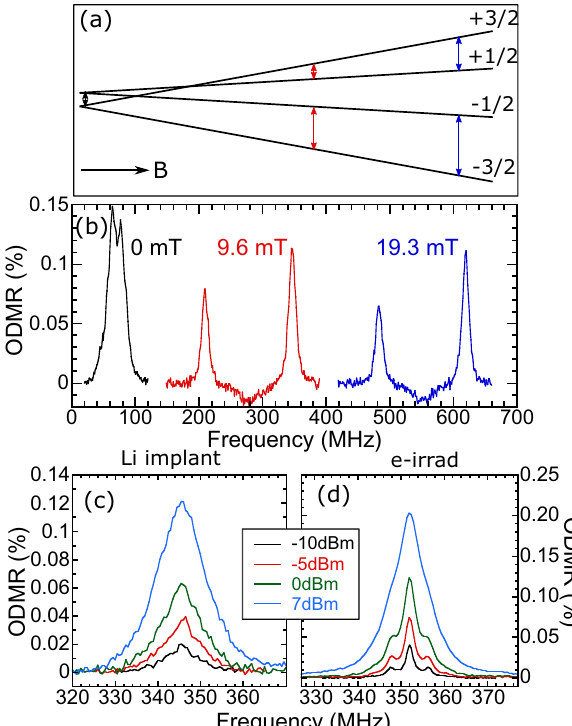
Figure 4. ( a ) Energies of the ground state S = 3/2 spin states of V 2 as a function of magnetic field along the c -axis, with arrows representing the ODMR transitions. ( b ) Room temperature ODMR of 5 × 5 µm square implanted at 1000 ions/spot (2.01 × 10 14 ions/cm 2 ) taken at three different magnetic fields along the growth axis. The average RF power is 7 dBm. ( c , d ) Room temperature ODMR of the ( c ) Li + implanted 5 µm × 5 µm square and ( d ) a reference 2 MeV electron-irradiated sample at about 10 mT for a series of RF